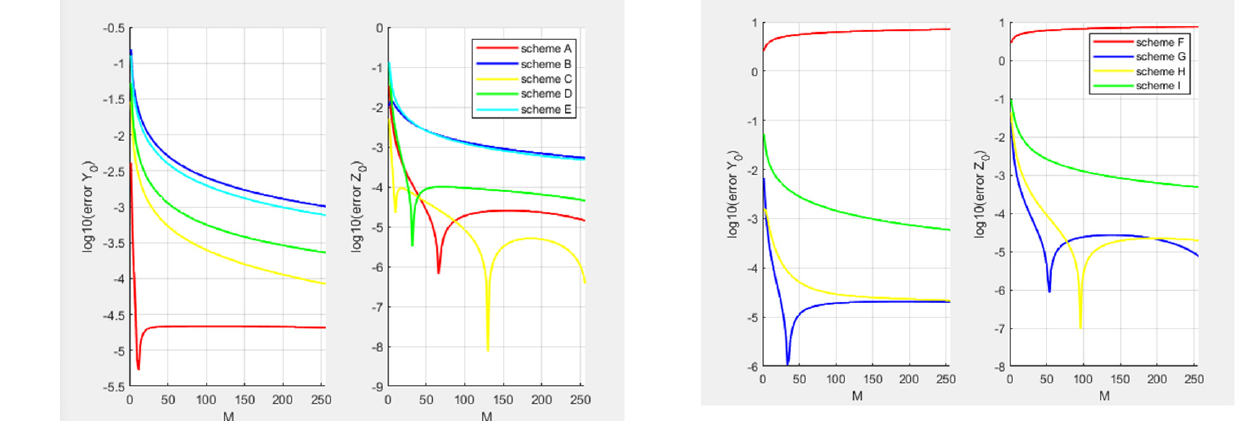
Figure 1. Convergence rate for different scheme.